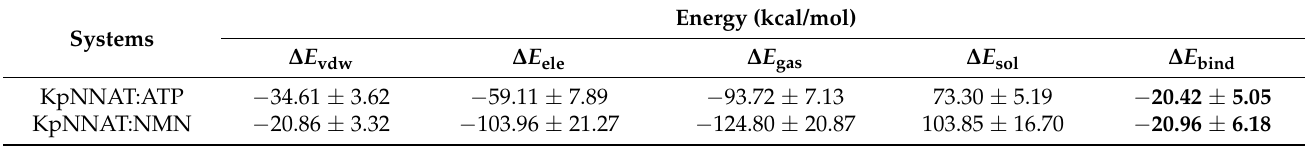
Table 6. The binding free energy profile (bold) of KpNNAT complex with ATP and NMN, as calculated using MM/GBSA method 7.